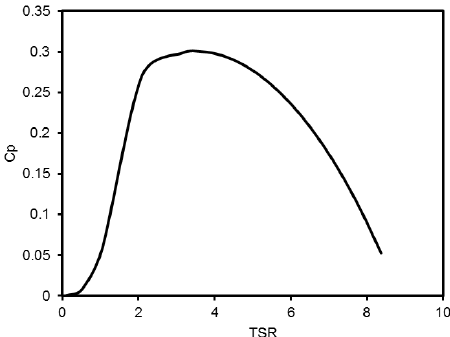
Figure 1. Designed pitch and normalized chords length in span wise. 162